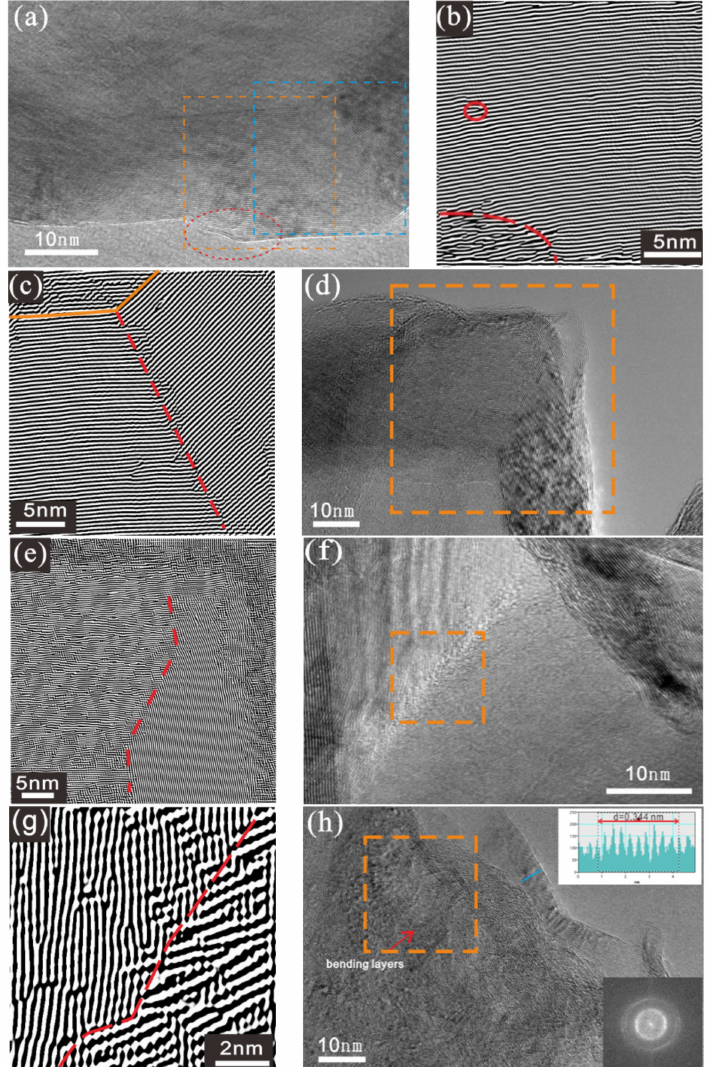
Figure 8. ( a ) Sample D60, several incomplete carbon layers outside sti ff layers. ( b ) The inverse fast Fourier transform (IFFT) image of the ROI (yellow dash line) in (a), showing few defects inside the graphite structure. ( c ) The IFFT image of the ROI (blue dash line) in (a), where arranged dislocations formed a dislocation wall (red dash line). ( d ) Sample F4-1 showing two local molecular orientations (LMOs) with di ff erent ordering and orientation. ( e ) The IFFT image of the ROI in (d). ( f ) Sample D60 showing two LMOs with di ff erent ordering and orientation. ( g ) The IFFT image of the ROI in (f), showing an irregular grain boundary. ( h ) Sample B7-1 showing locally ordered graphite structure and bending layers; the right upward inset is the lattice intensity profile along the blue line, the lower right corner inset show the blurred di ff raction